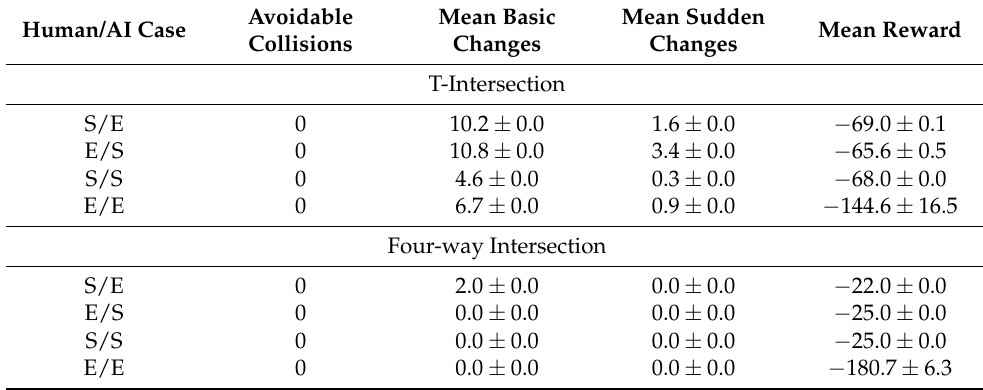
Table 10. Human: weather, AI: sensor and mask. Test results for manager performance and behavior. Human/AI